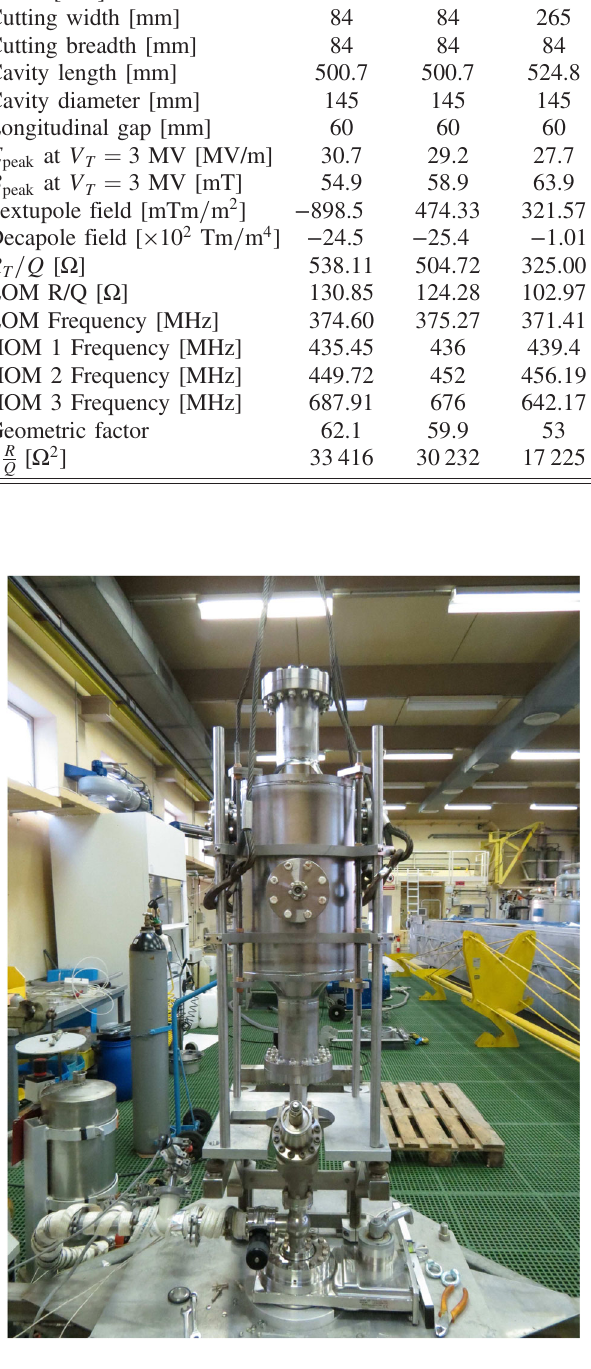
FIG. 21. Cross-sectional diagram of final cavity design C (a) and an isometric view